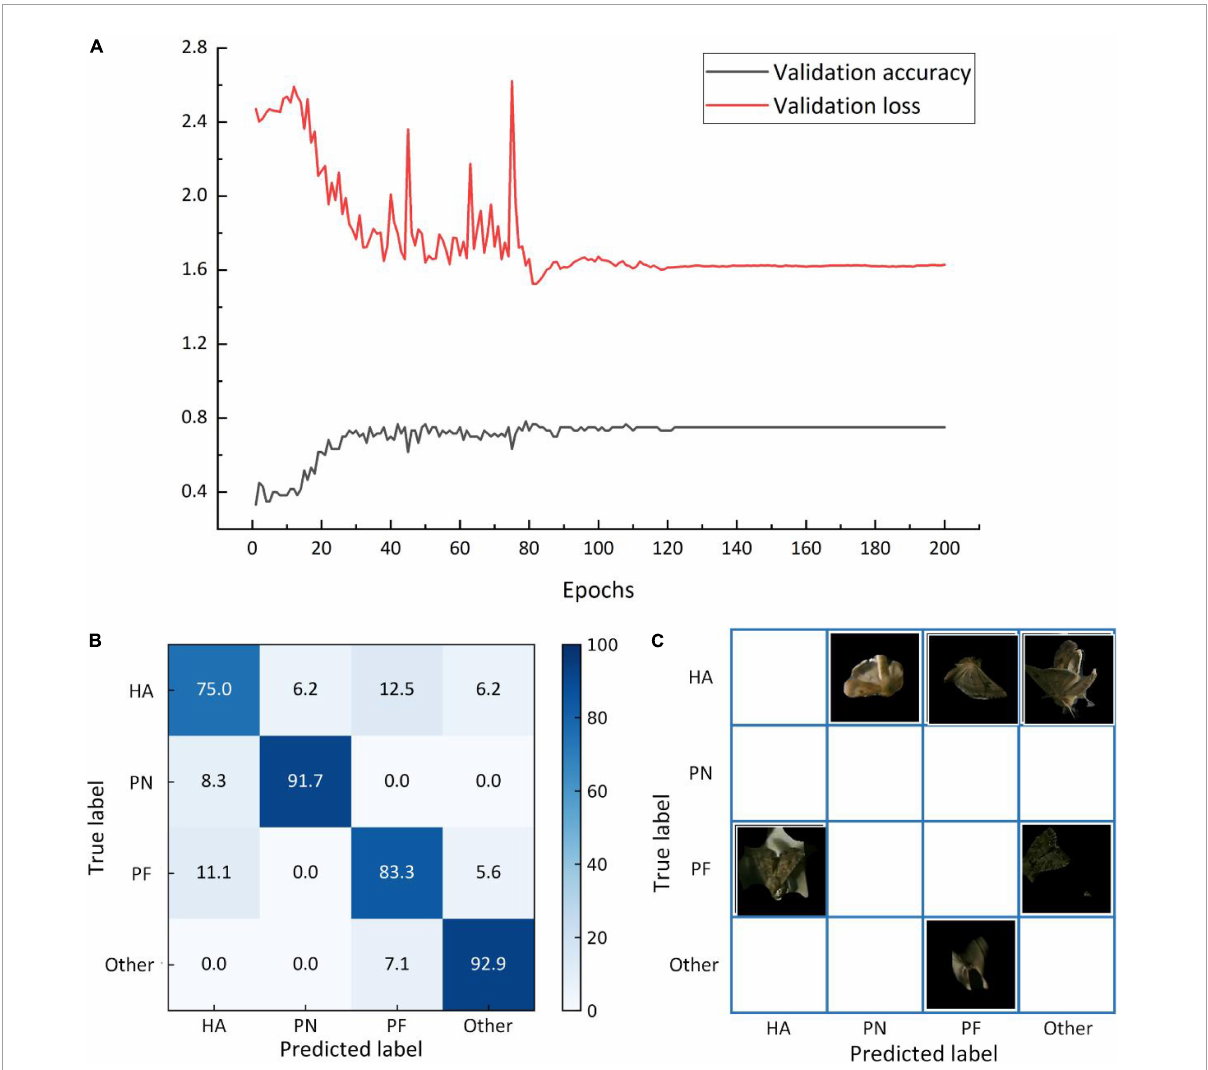
FIGURE11 The average identification accuracy and error curves based on the validation set (A) , matrix of the average identification accuracy based on the test set (B) , and matrix of the misclassified images based on the test set (C) for the model trained on the symmetric mixed